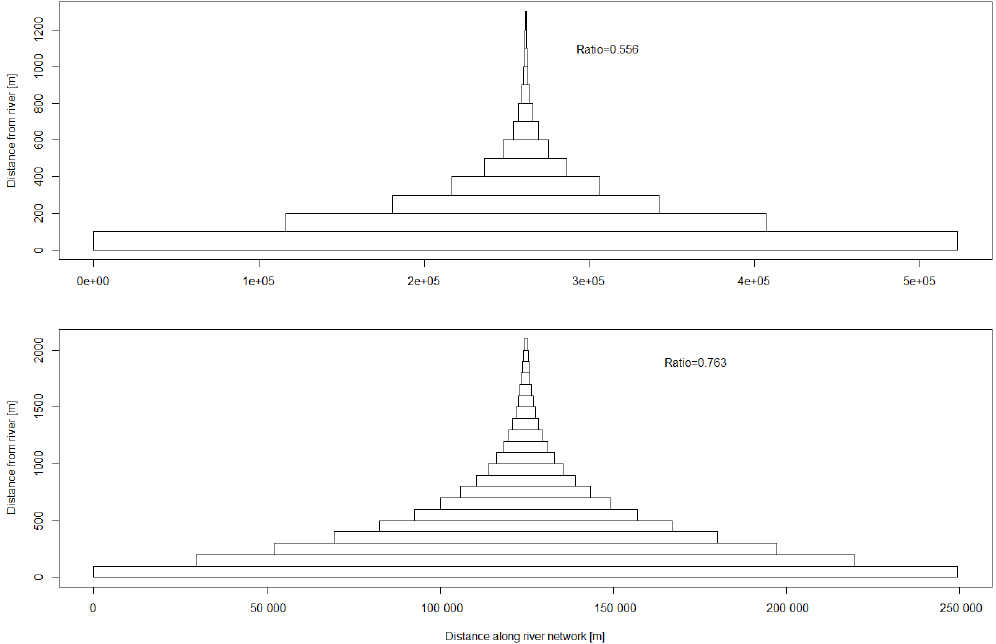
Figure A1. Fractional catchment area as a function of distance from the river network for the same two catchments as in Fig. 2. The ratio, κ , between consecutive areas is